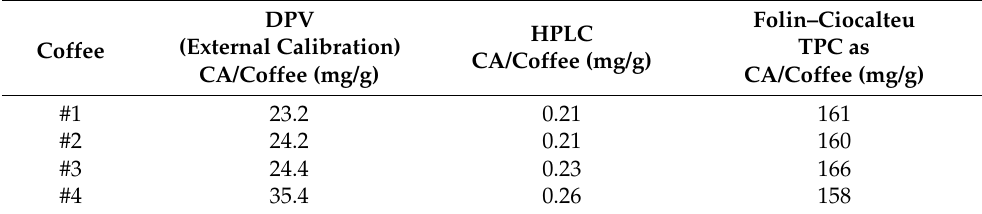
Table 3. Comparison between the results of different analytical